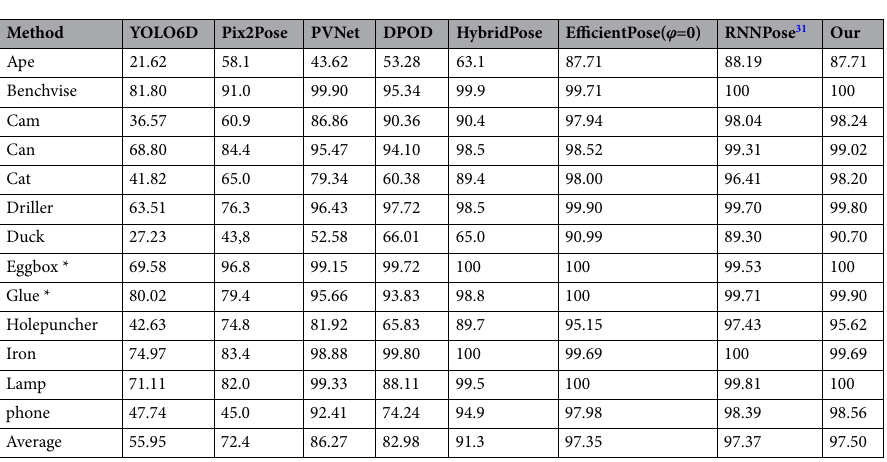
Table 1. Evaluation and comparison on the Linemod dataset in terms of the ADD(-S) metric. Symmetric objects are marked with * ).